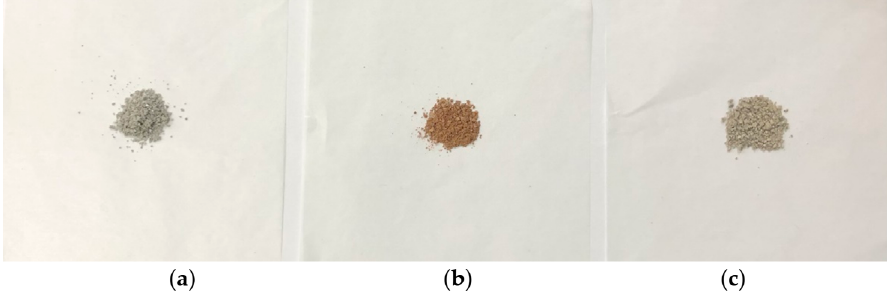
Figure 2. Phosphor powders after calcination. ( a ) = BAM phosphors; ( b ) = CAT phosphors; ( c ) = TRI phosphors. (The size of the weighing paper is 9 cm × 9